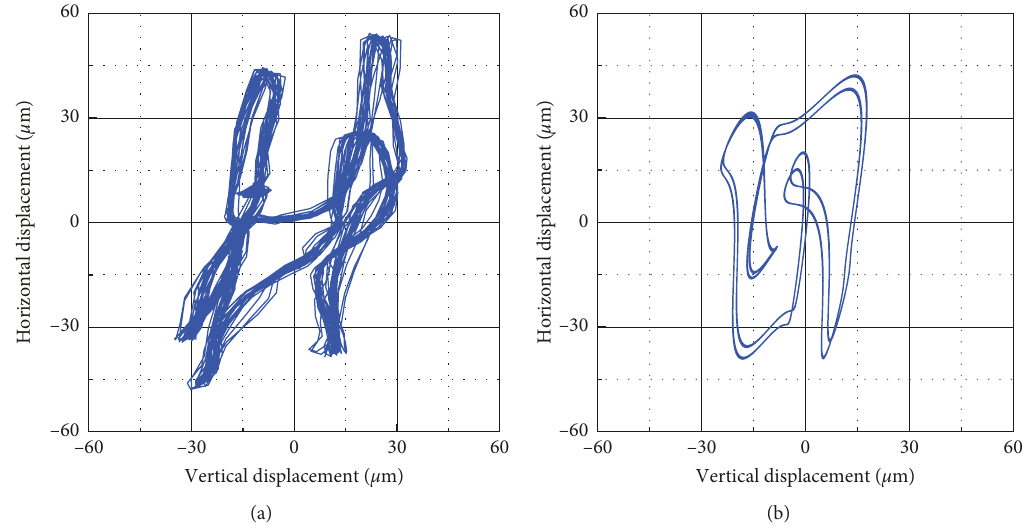
Figure 12: Comparison of the orbits under heavy rub-impact condition. (a) Experimental result. (b) Numerical result.